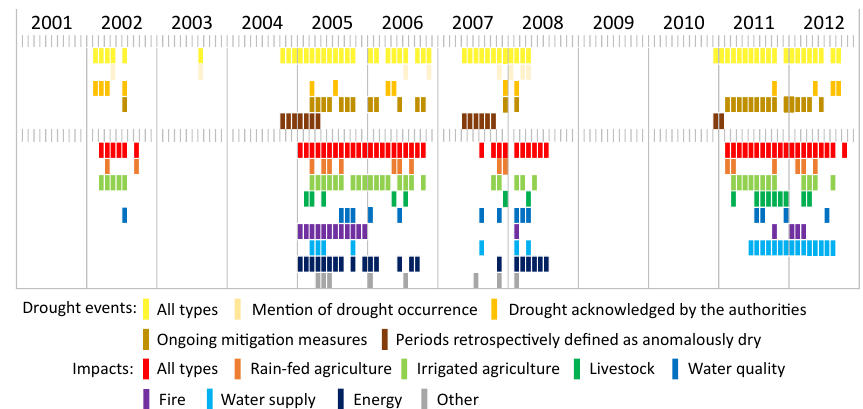
Figure 2. Timeline of drought events (upper part) and impacts (lower part) for the north-eastern Ebro Basin during the period 2001 to 2012 based on a comprehensive local newspaper